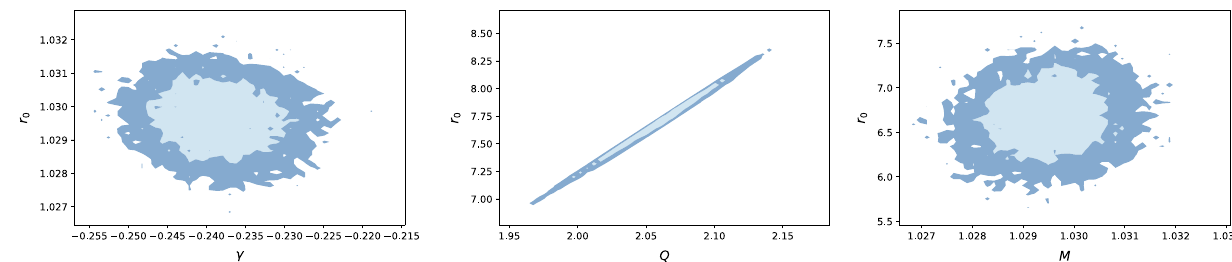
Fig. 3 The constrains of WH parameters ( r 0 ,γ, Q , M ) using the parameter space for three different WH models with 68% and 96% confidence contours